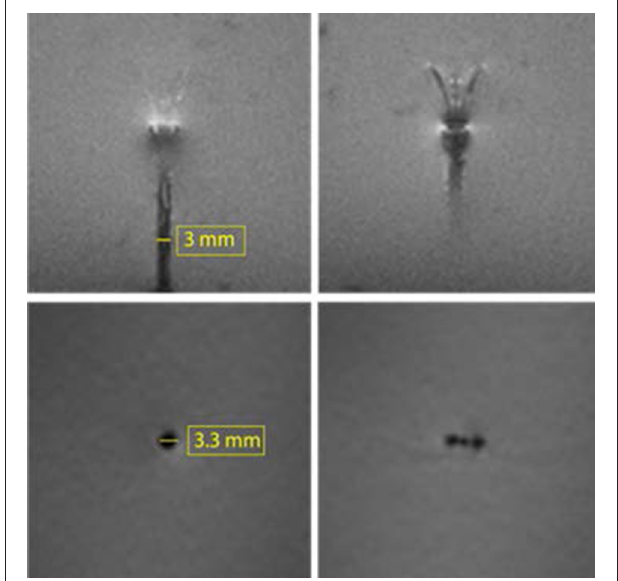
FIGURE 3 | 3T MRI of the MINT device in an agarose brain phantom. Top: two consecutive slices in the sagittal plane showing the shaft and the microcannula extended in Position 1 (intermediate extension). Bottom: transverse plane images of the (left) shaft and (right) microcannulas (Slice thickness: 1.3mm).